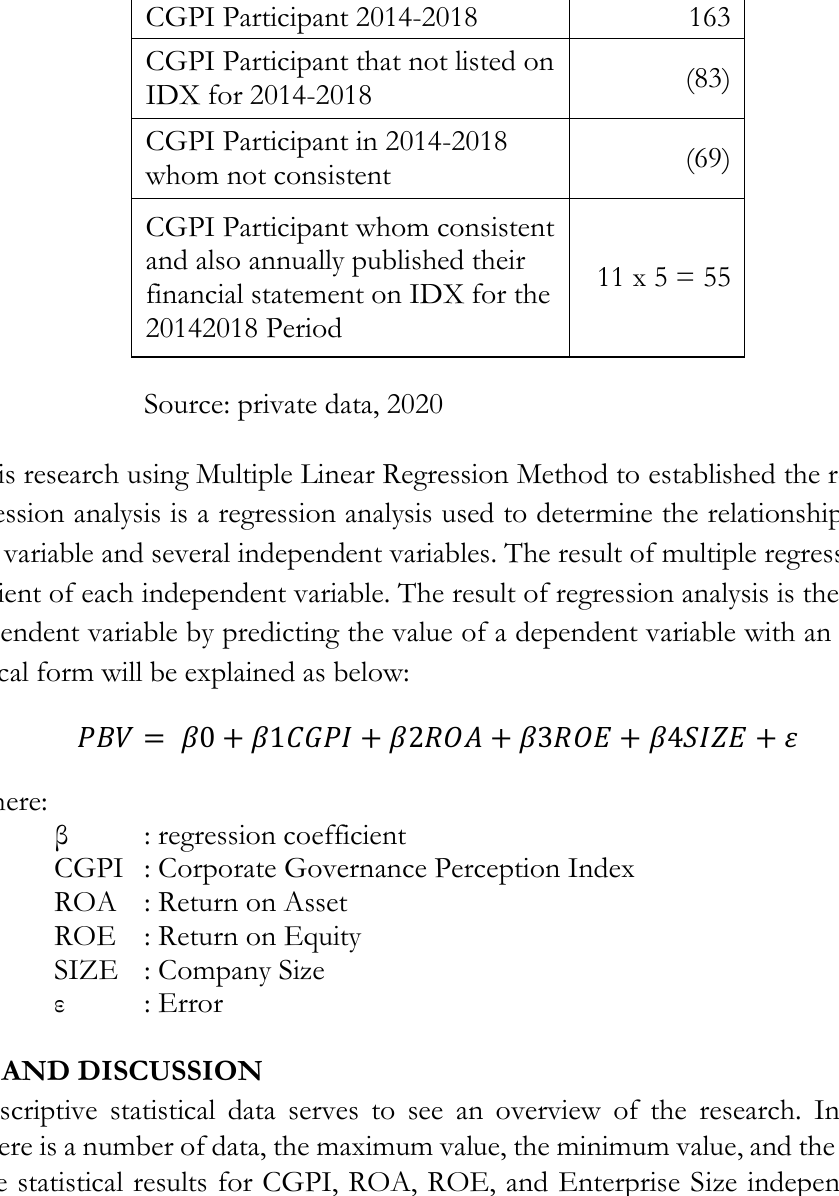
Table 2. Descriptive Statistic